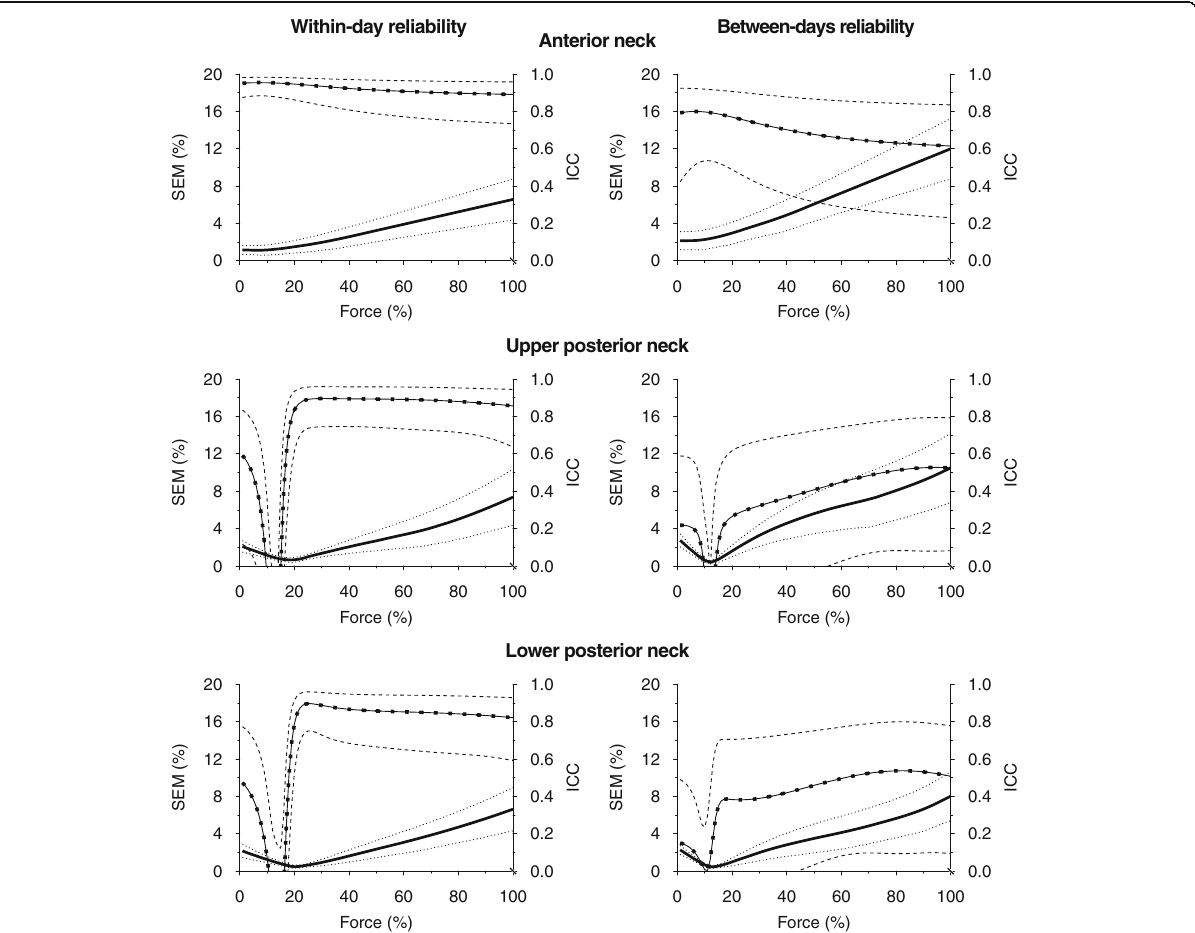
Fig. 5 Test-retest reliability of the EMG-force relationship over the full force range. Solid lines denote point estimates of the standard error of measurement (SEM), and dotted lines its 95% confidence interval (CI). Lines with squares marks point estimates of the intraclass correlation coefficient (ICC), and dashed lines its 95%